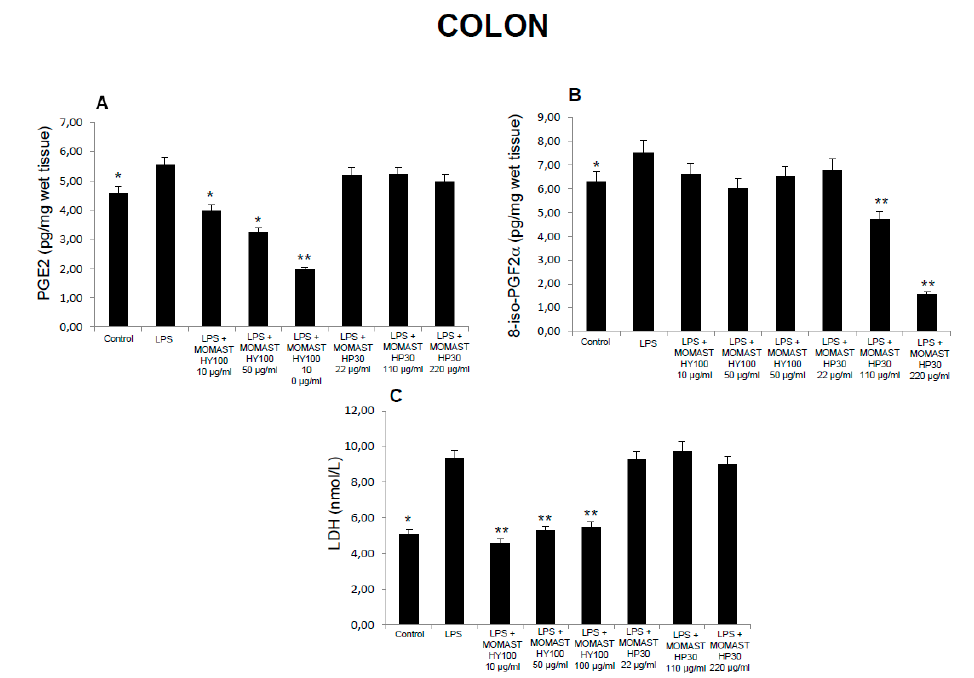
Figure 2. Effects of MOMAST( ® ) HY100 (10, 50, and 100 µg/mL) and MOMAST( ® ) HP30 (22, 110, and 220 µg/mL) on ( A ) PGE 2 levels (pg/mg wet tissue), ( B ) 8-iso-prostaglandin F 2 α (8-iso-PGF 2 α ) levels, and ( C ) lactate dehydrogenase (LDH) activity (nmol/L) in colon specimens. Data were reported as means ± SEM. ANOVA, P < 0.01; post-hoc test, * p < 0.05, ** p < 0.01 vs. LPS-treated group.